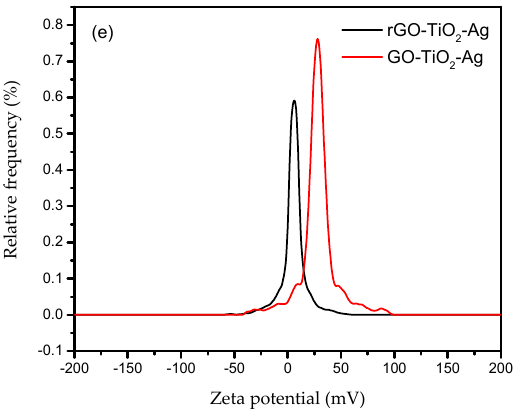
Figure 3. ( a ) Raman spectroscopy of THNp, ( b ) FTIR of THNp, ( c ) XRD of THNp, ( d ) Particle Size Distribution of THNp, ( e ) Zeta potential of THNp.